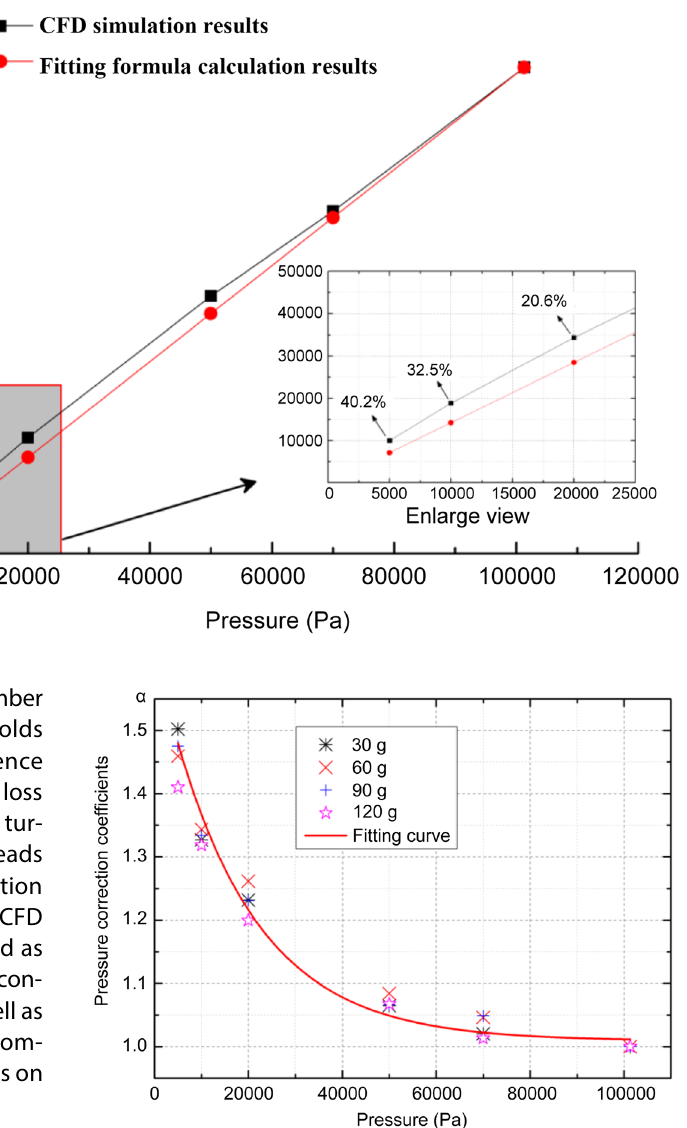
Fig. 16 Pressure correction coefficient